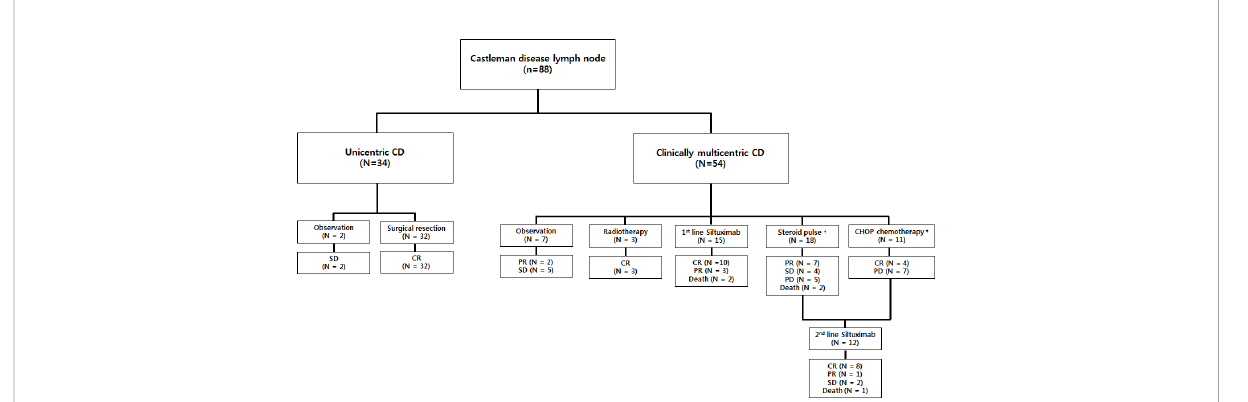
FIGURE 1 Treatment outcomes of patients with CD (N=88). Two patients with UCD and 7 with MCD were observed without any treatment after diagnosis. Among these nine patients, seven had SD. Thirty-two patients with UCD underwent surgery and achieved CR (ORR, 100%). Three patients with localized MCD received radiotherapy and achieved CR (ORR, 100%). Forty-four patients underwent systemic therapy: 18 received steroid pulse therapy (ORR 38.9%), 11 received CHOP chemotherapy (ORR 36.4%), and 15 received frontline siltuximab infusion (ORR 86.7%). Five patients from the steroid-treated group and seven from the CHOP chemotherapy group, who exhibited PD, received salvage siltuximab infusion (ORR 75.0%). All deceased patients were due to MCD disease progression. † Steroid pulse therapy represents receiving methylprednisolone ≥ 1.0 mg/ kg/day. ‡ CHOP chemotherapy consisted of cyclophosphamide (750 mg/m 2 ), vincristine (1.4 mg/m 2 ), rituximab (375 mg/m 2 ) on day 1, and prednisolone (60 mg/m 2 ) on days 1 – 5 every 21 days, or intravenous siltuximab infusion. CD, Castleman disease; SD, stable disease; CR, complete remission; PR, partial remission; PD, progressive disease; UCD, unicentric Castleman disease; MCD, multicentric Castleman disease; ORR, overall response